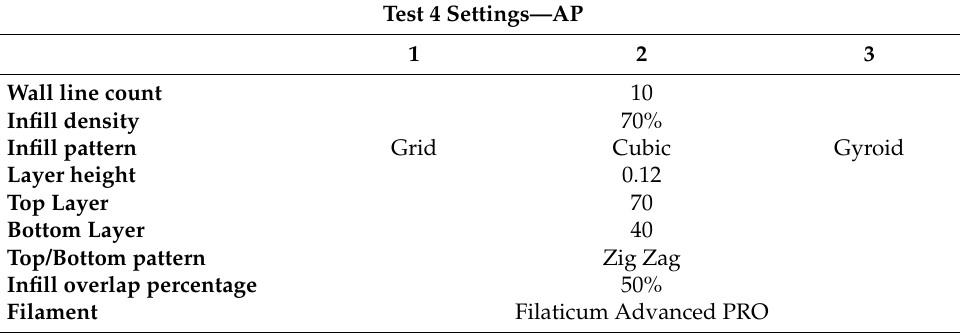
Table 9. Punch settings of Test 4—AP.